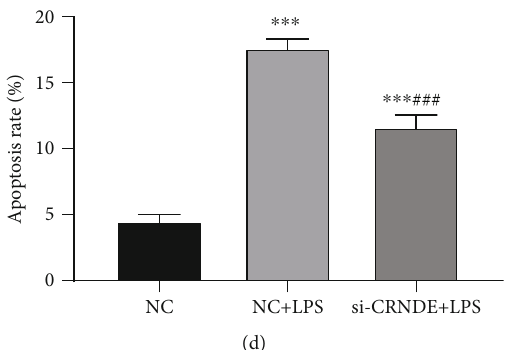
Figure 3: CRNDE promotes apoptosis in HK-2 cells. (a and b) Apoptosis of HK-2 cells that overexpressed CRNDE compared with the control group, ∗∗ p < 0 : 01 . (c and d) Apoptosis of silenced CRNDE cells treated with LPS: ∗∗∗ p < 0 : 001 and ### p < 0 : 001 compared with NC+LPS in the control group.